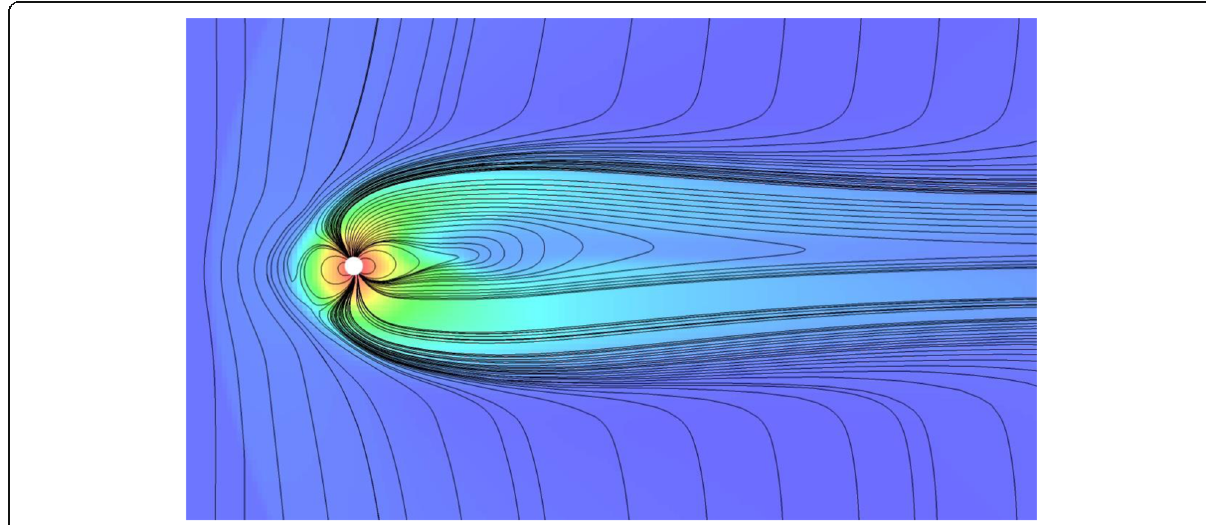
Fig. 11 Simulation of the interactions of solar wind with the Earth ’ s magnetosphere. A plane perpendicular to the solar ecliptic (xz plane) is depicted. Earth is denoted by the white circle. Nearly vertical black contours on the left of the image indicate the solar wind magnetic field, whereas curved black lines — one or two ends of which are rooted on Earth — indicate the Earth ’ s magnetospheric field following a dynamic equilibrium with the solar wind. Magnetic reconnection and other fluid dynamical and MHD processes play critical roles in determining the impact of stellar magnetized winds and storms on planetary magnetospheres and atmospheres. These processes can lead to atmospheric mass loss or injection (via plasma flows through reconnected field lines), and over long timescales can influence planetary habitability. The above simulation was performed using CESSI-SPIM (Das et al.